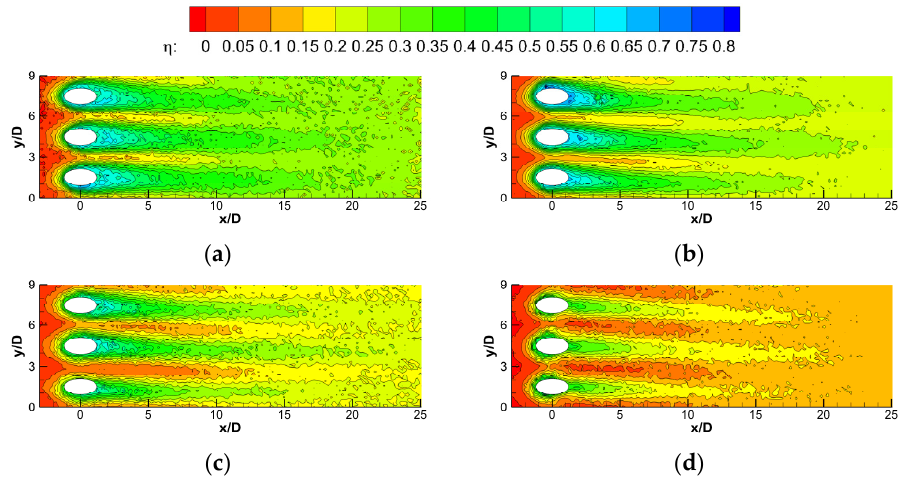
Figure 10. Distribution of film effectiveness at different blockage ratios, M = 1.4. ( a ) B = 0; ( b ) B = 0.2; ( c ) B = 0.5; ( d ) B = 0.8.